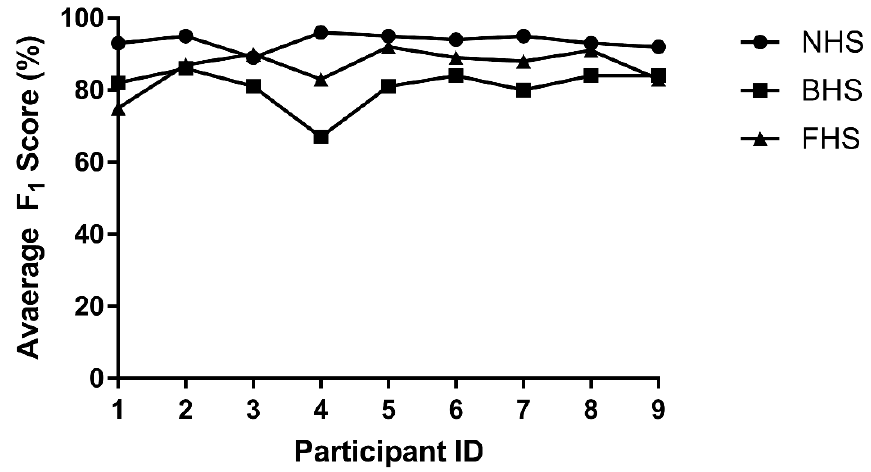
Figure 13. LOSOCV result for the heel slip classifier. NHS represents non-toe slips, BHS represents backward toe slips, and FHS represents forward toe slips. Table 6. Heel slip classifier performance.